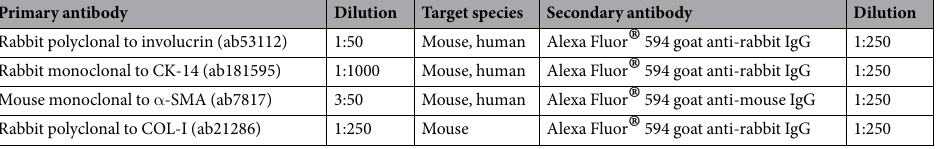
Table 1. List of primary and secondary antibodies